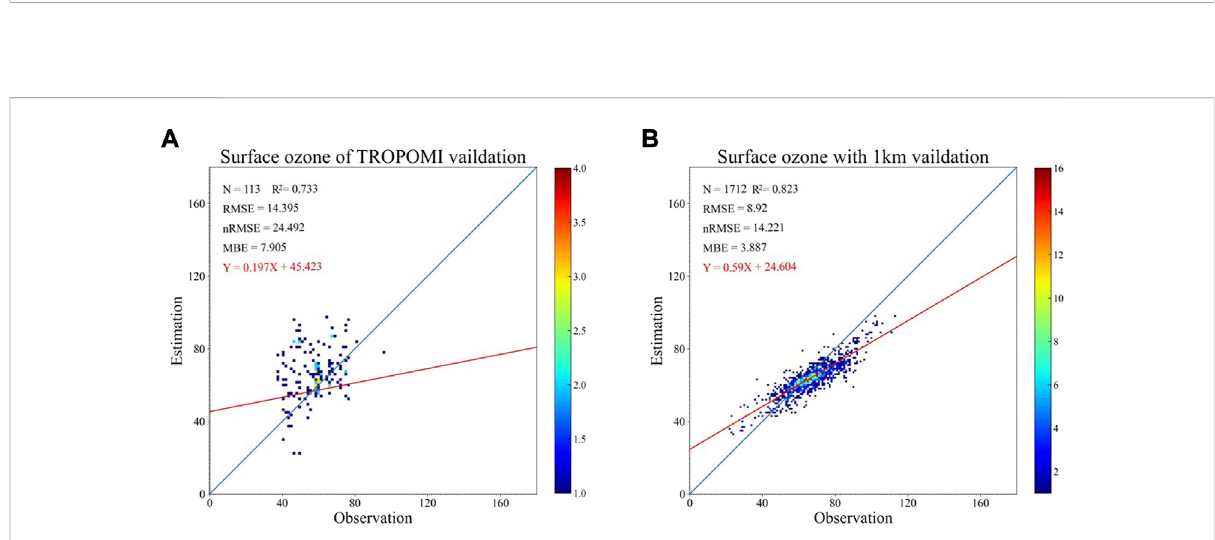
FIGURE 9 Validation of surface O 3 concentration downscaling results (23 November 2021). (A) Validation of original 30 km TROPOPMI surface O 3 concentration data and (B) validation of downscaled 1 km TROPOPMI surface O 3 concentration